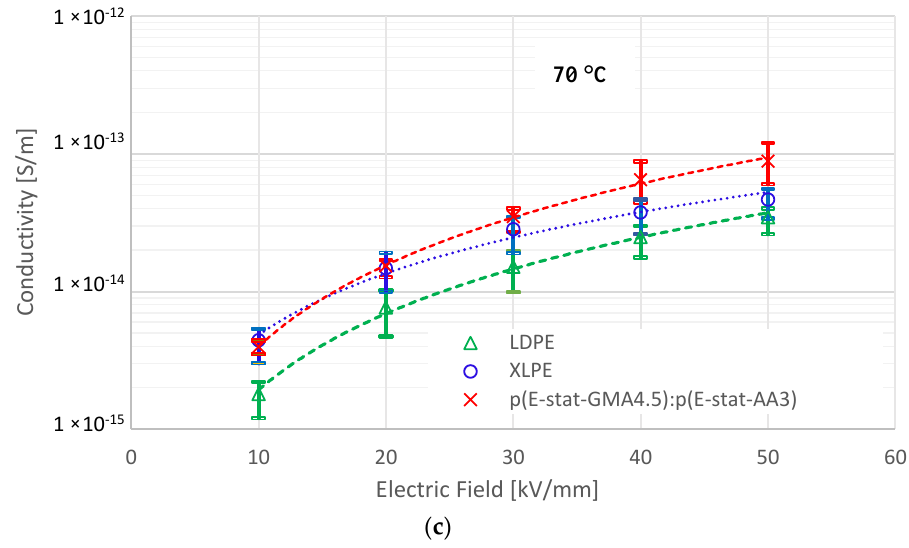
Figure 5. Variations of DC conductivities of the studied materials (measured via charging current) with the electric field strength at temperatures of ( a ) 30 °C, ( b ) 50 °C, and ( c ) 70 °C.